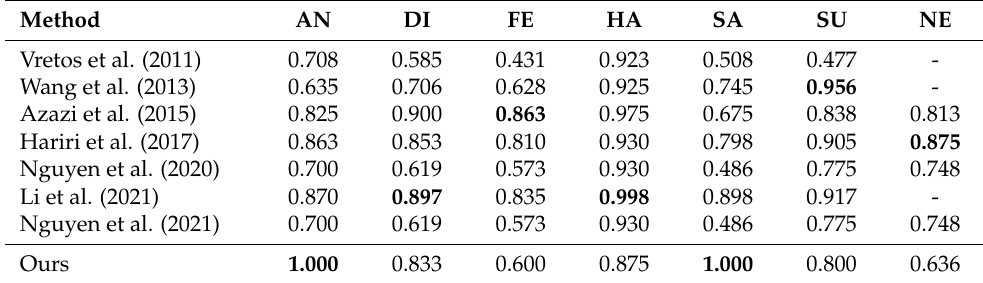
Table 3. Comparison of classification accuracy with different methods on the Bosphorus dataset, the best results in each expression are emphasized with